Question: Summarize what this figure shows in one sentence.
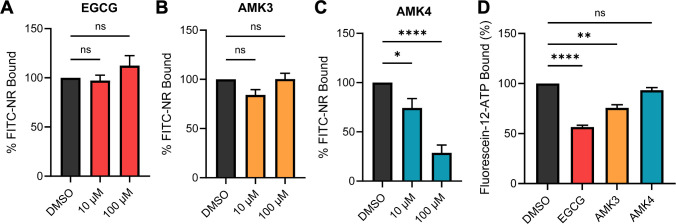
Answer: AMK3 and AMK4 differentially affect Pf Hsp70-1 peptide and ATP binding. FITC-NR peptide (10 nM) binding to Pf Hsp70-1 (1.3 µM) in the presence of EGCG ( A ), AMK3 ( B ), or AMK4 ( C ). ( D ) F12-ATP (5 nM) binding to Pf Hsp70-1 NBD (100 nM) in the presence of EGCG, AMK3, and AMK4 (100 µM). ( A–D ) Data shown as average ± SEM ( n = 3–5). * P < 0.05; ** P < 0.01; **** P < 0.0001; ns, not significant (unpaired t-test) relative to DMSO control.